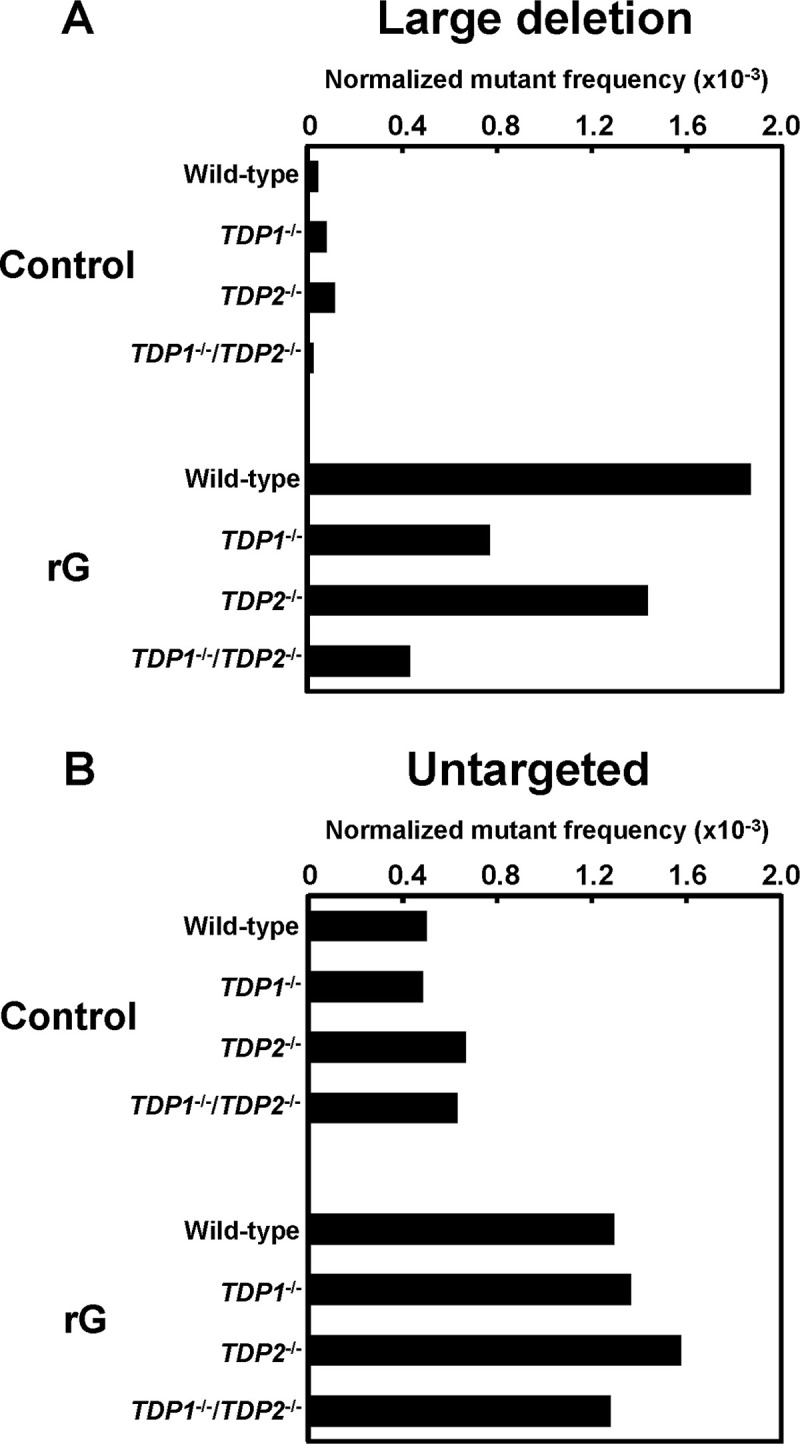
The normalized mutant frequencies of (A) large deletion and (B) untargeted mutations detected in the supF gene in the plasmids replicated in the wild-type, TDP1-/-, TDP2-/-, and TDP1-/-/TDP2-/- cells. The frequency values of each mutant were calculated based on the number of mutants represented in Table 1. A significant difference was determined based on the number of mutations shown in Table 1.